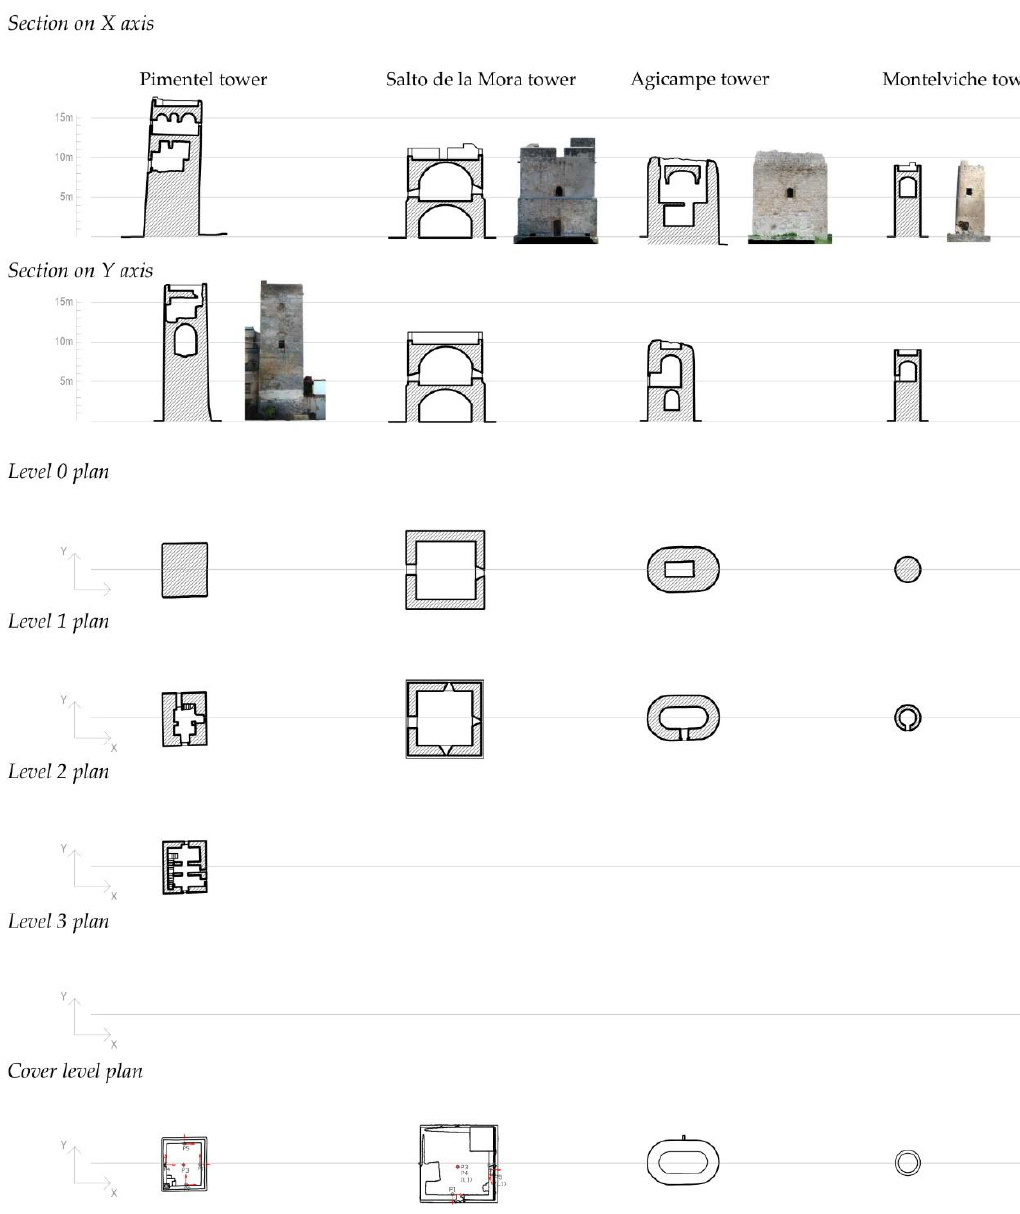
Figure 3. Description of elevations and plans of towers in this study .